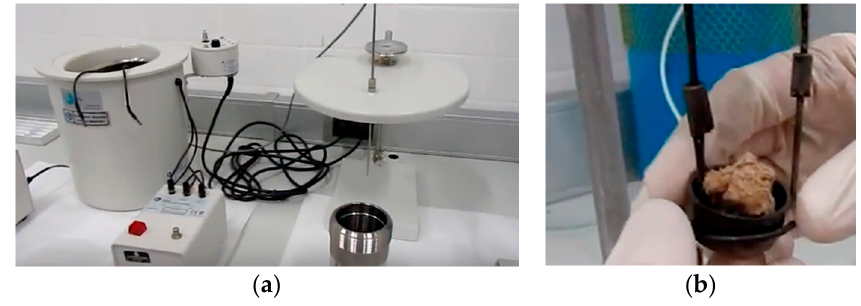
Figure 2. ( a ) Oxygen bomb calorimeter; ( b ) Sample in bomb calorimeter.